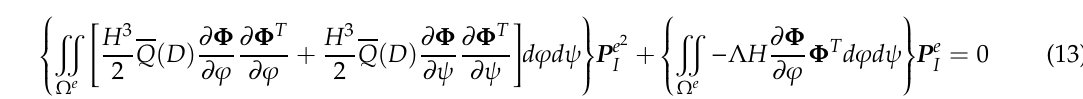
Figure 5. Rectangular solution domain and mesh